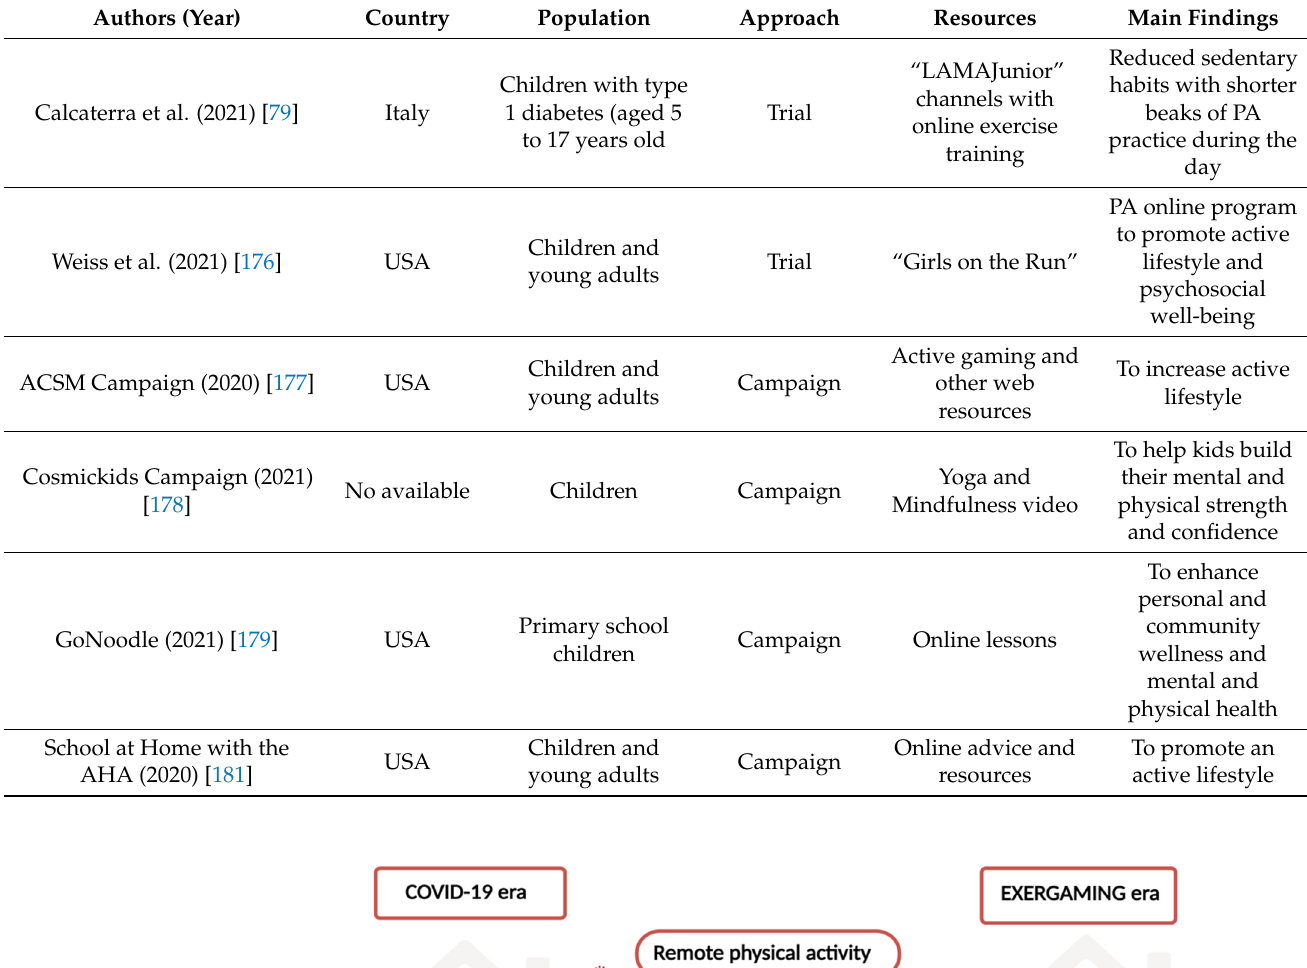
Table 2. Studies on online training pre- and during the COVID-19 era.